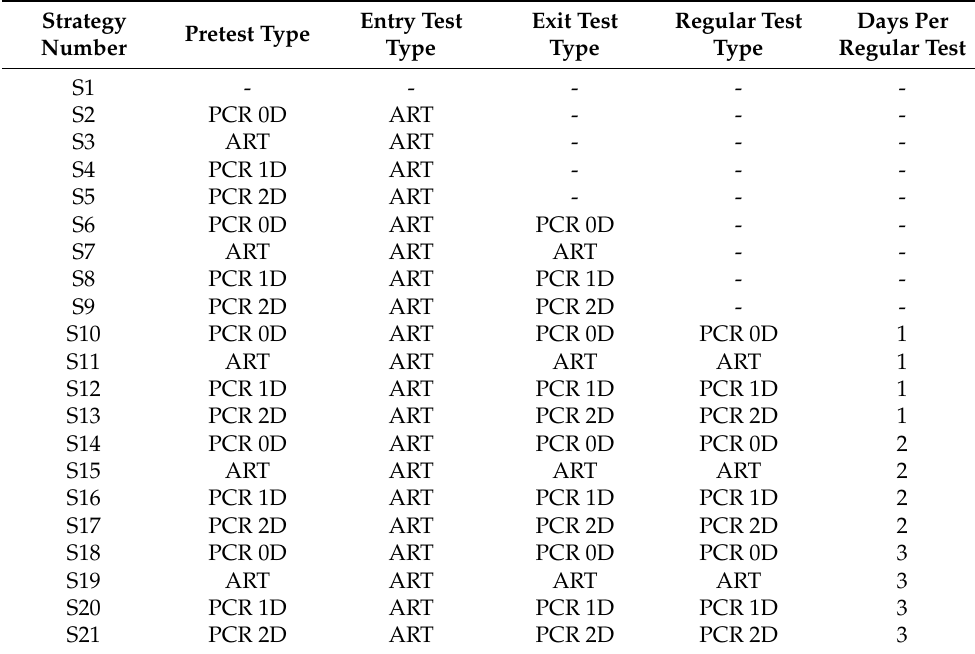
Table 1. Policies modelled. PCR 0D denotes a PCR test with a 0-day turnaround time, PCR